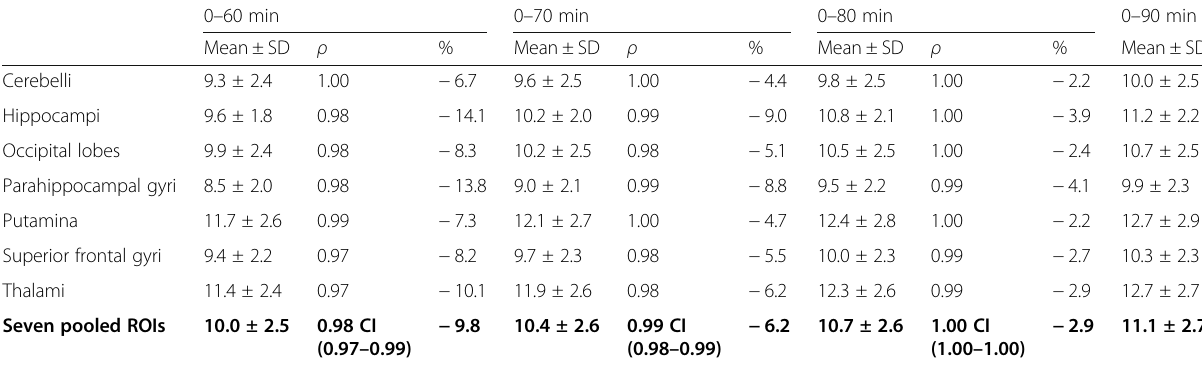
Table 1 Original ppIF-derived V T calculated over various intervals versus original ppIF-derived V T calculated using the 90-min datasets, via voxelwise SA